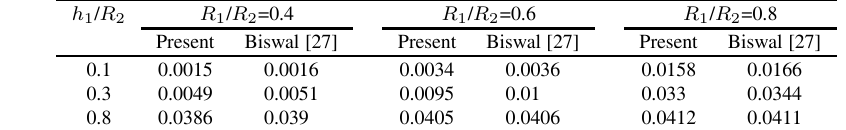
Table 1 Maximum slosh displacements ( m ) at the container